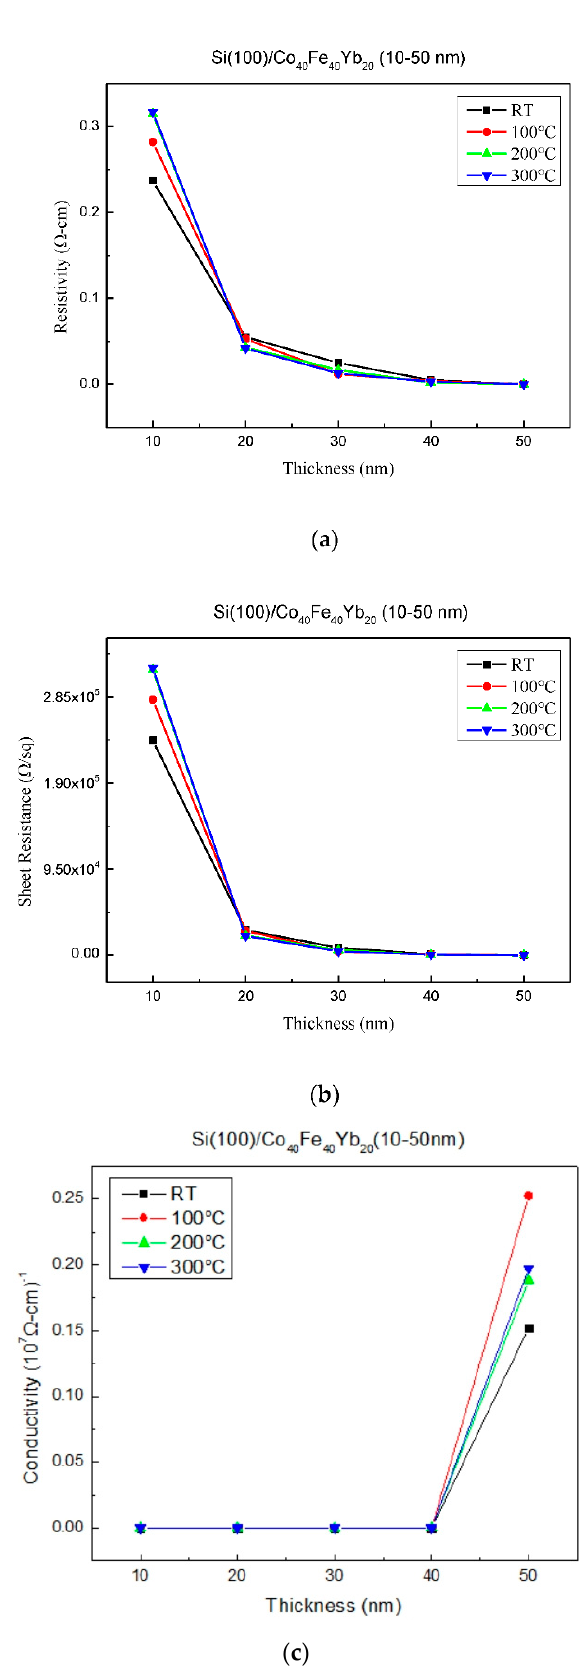
Figure 6. ( a ) Resistivity, ( b ) sheet resistance, and ( c ) conductivity of Co 40 Fe 40 Yb 20 thin films.